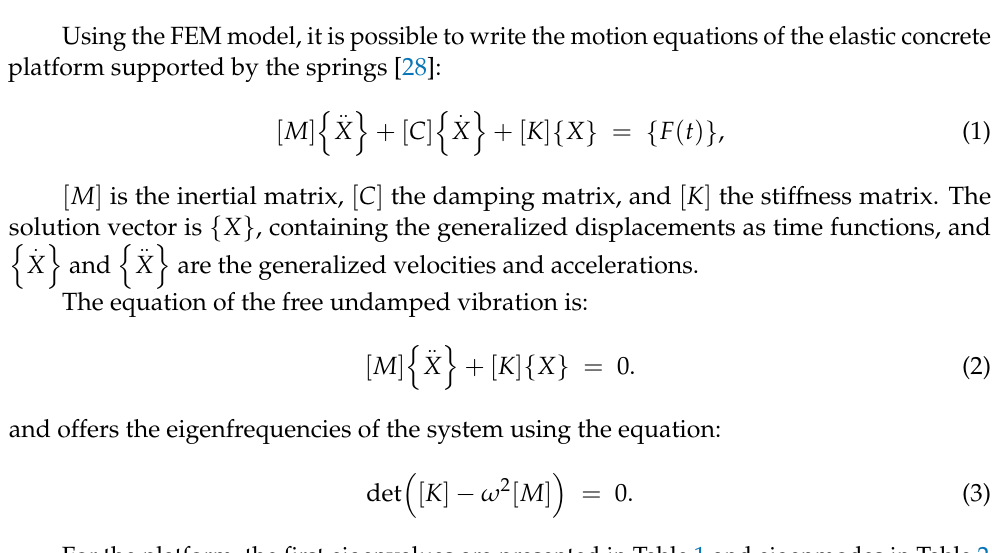
Figure 5. The inertial platform supported by elastic spring under a harmonic excitation of the ground.